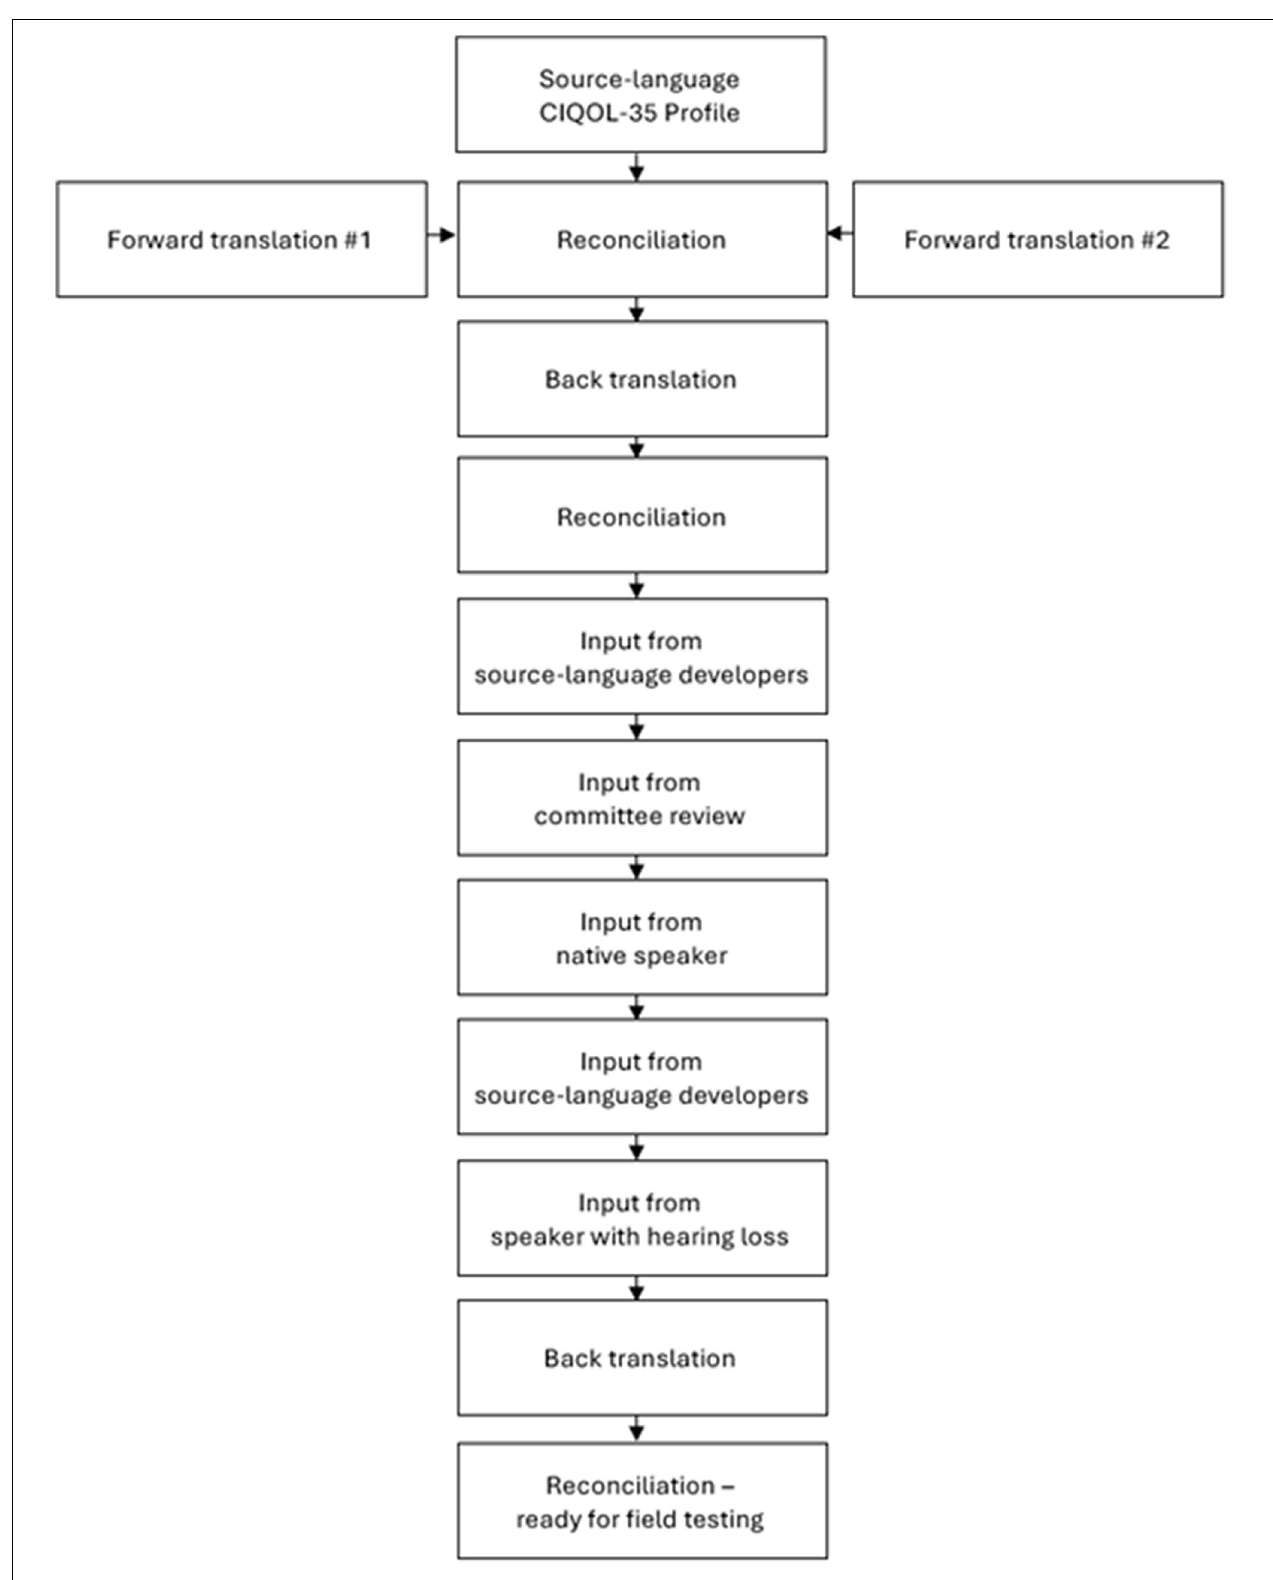
FIGURE 1 | Translation and cross-cultural adaptation process of the CIQOL-35 Profile from English to French.